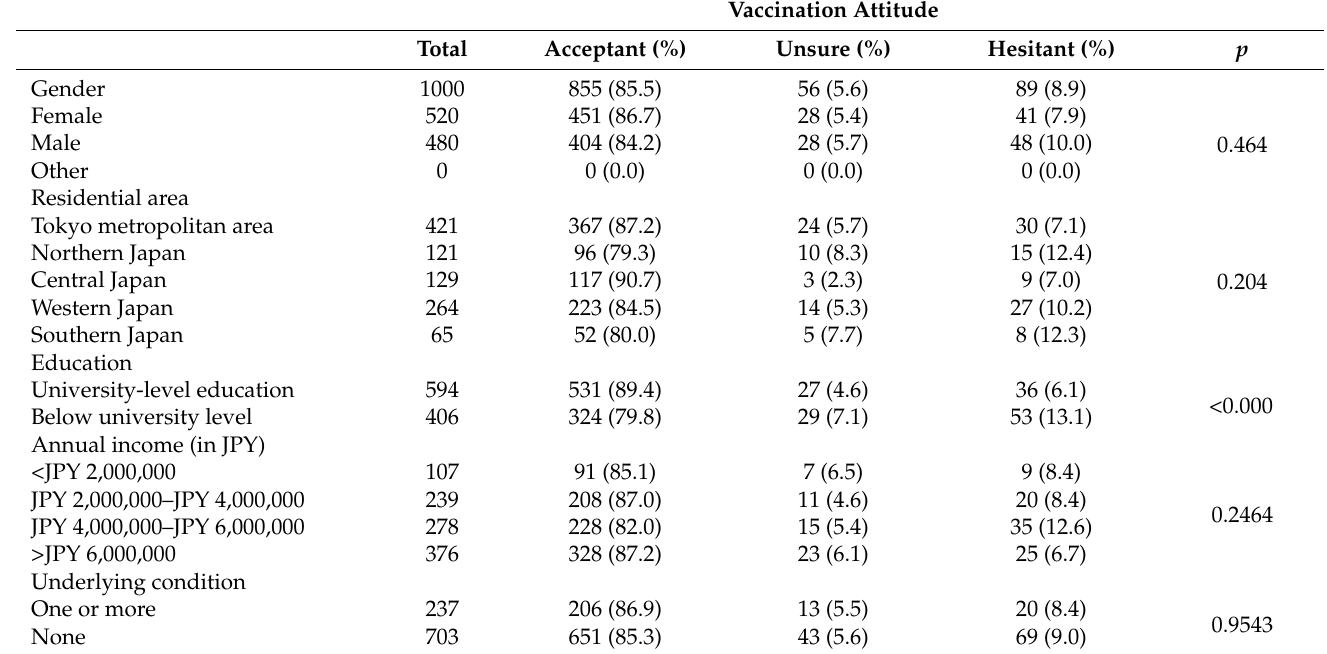
Table 2. Participants’ characteristics and vaccination attitude in September 2021.